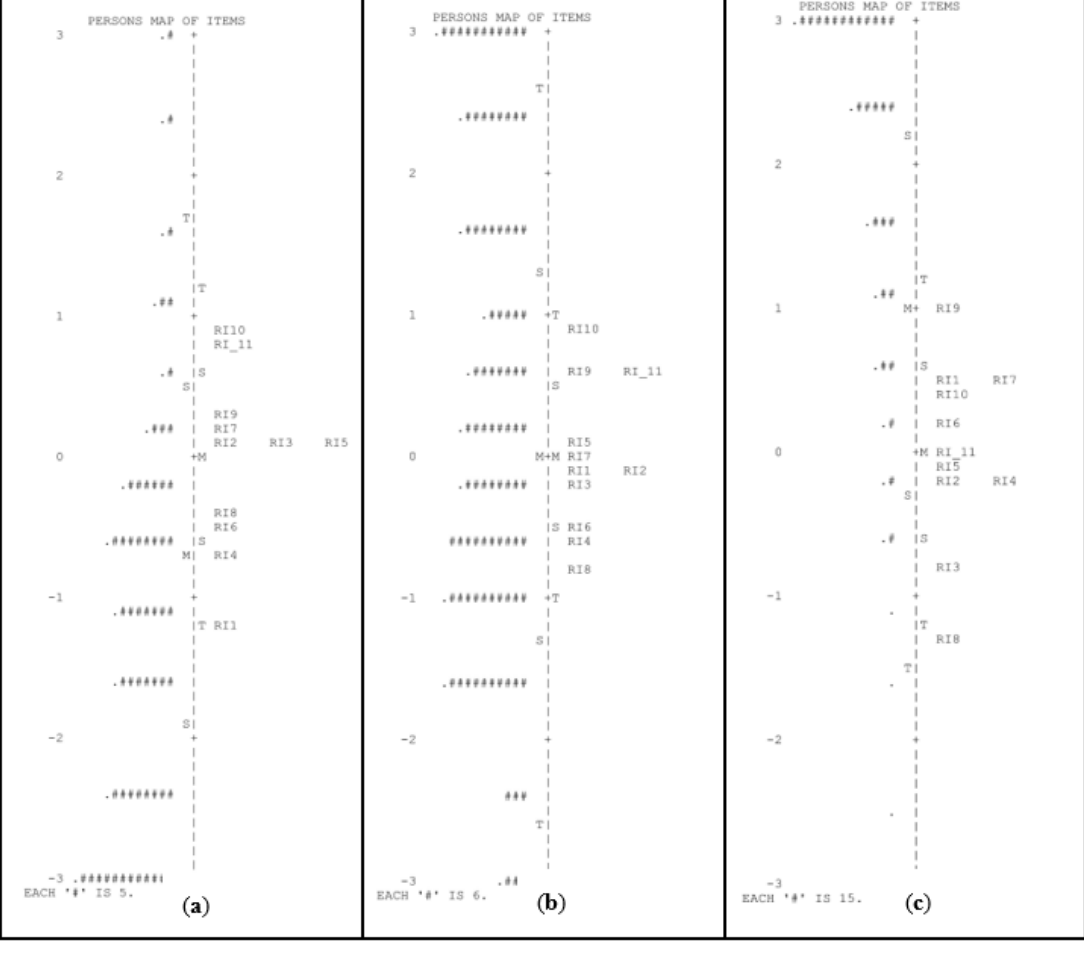
Figure 2. Person–item maps for the task of phonological awareness of the final syllable in pre-K ( a ), kindergarten ( b ), and first grade of primary school ( c ) . # Refers to the number of persons.